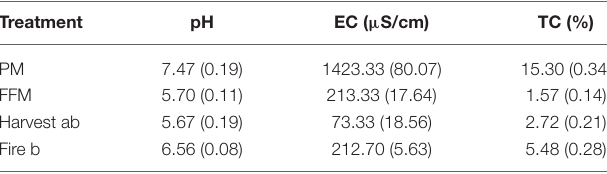
Frontiers in Environmental Science |